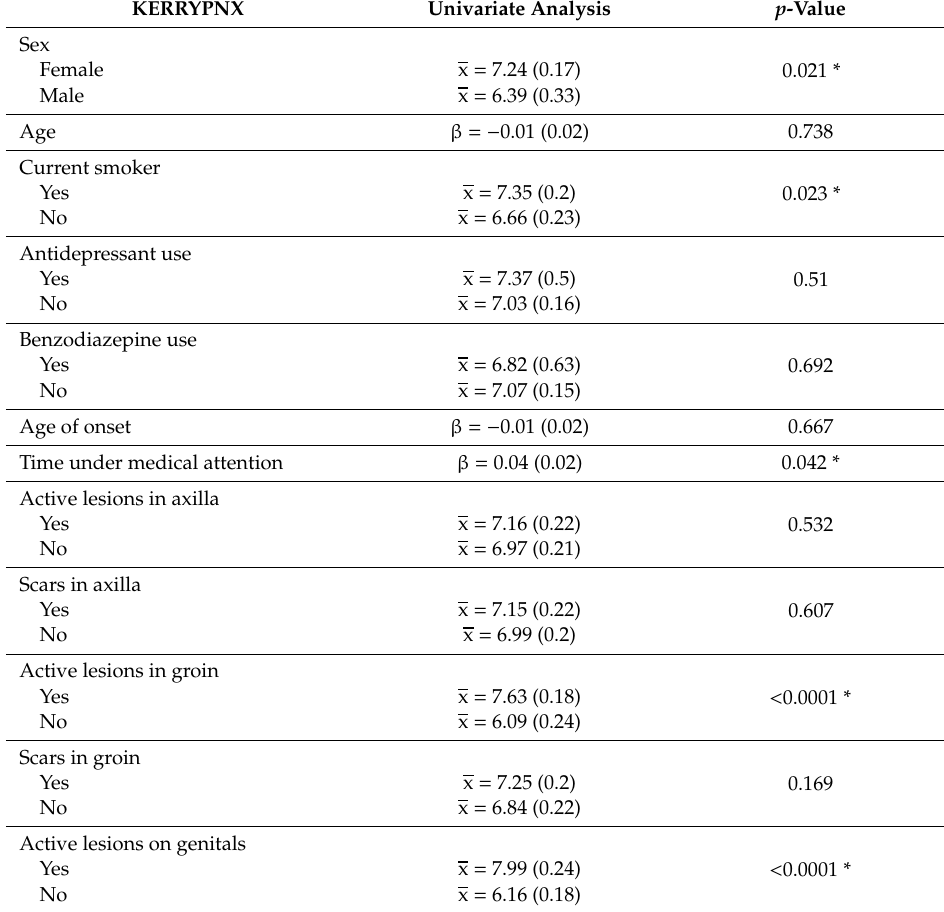
Table 3. Univariate analysis of factors associated with sexual distress in patients with